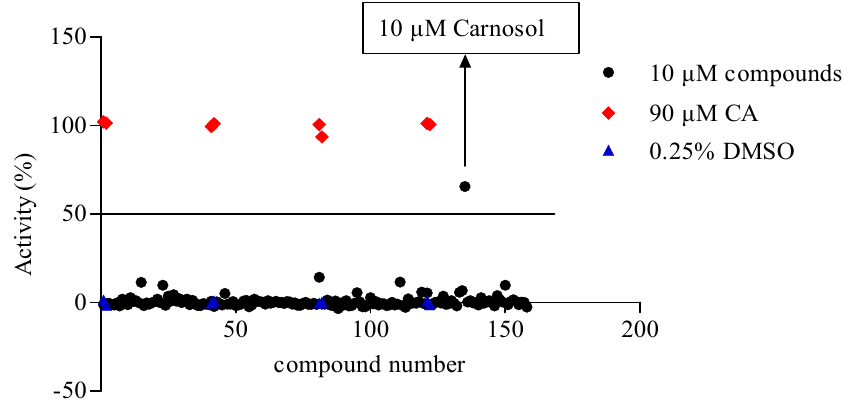
Figure 3. Scatter plot of a collection of 158 Traditional Chinese medicine (TCM) compounds (10 μ M). Each dot represents one compound. Ninety μ M CA (red dot) and 0.25% DMSO (blue dot) were used as the positive and negative control, respectively. Hits above the cutoff value (50%) were picked for